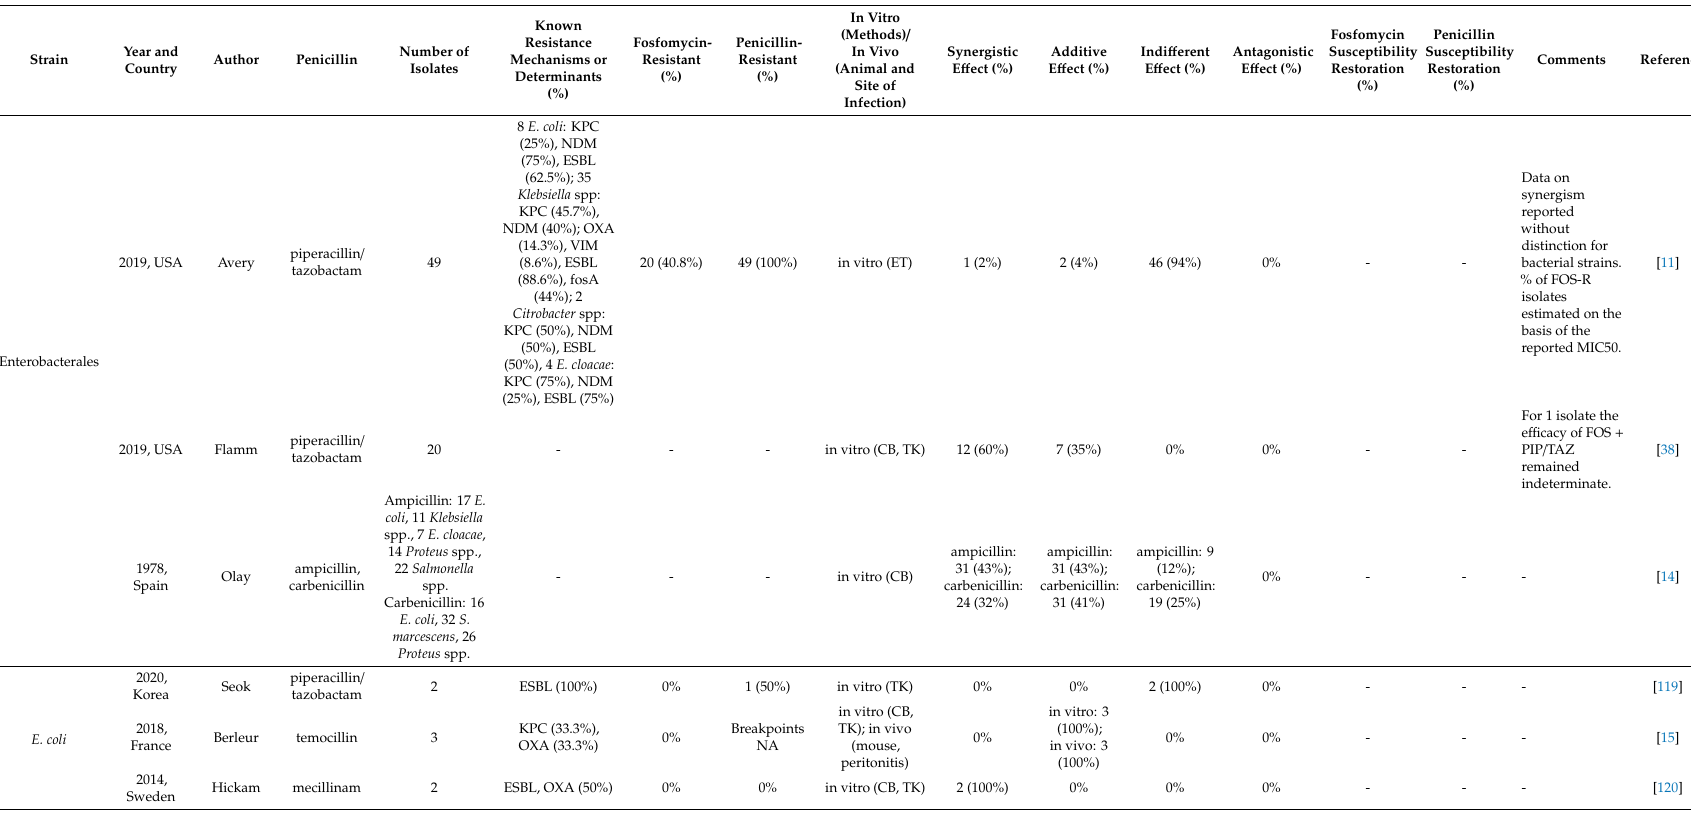
Table 1. Studies on combination between fosfomycin and penicillins, penicillins + β -lactamase inhibitors, penicillinase-resistant penicillins. CB: checkerboard assay; TK: time–kill assay; ET: